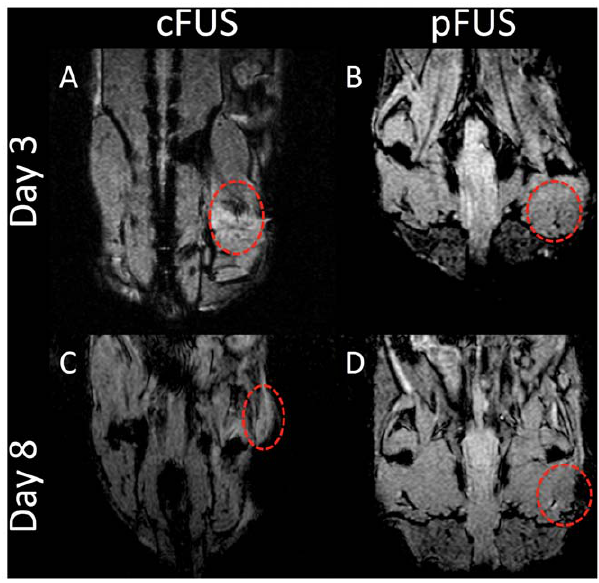
Figure 2. Evaluation of FL-SPION-labeled macrophage migra- tion to FUS-treated muscle tissue by MRI. T 2 *-weighted MR images were obtained at 3T after 3 ( A and B ) and 8 ( C and D ) days post-FUS. Imaging reveals hypointense voxels in regions of the right leg that were treated with cFUS ( A and C ) or pFUS ( B and D ) exposures.